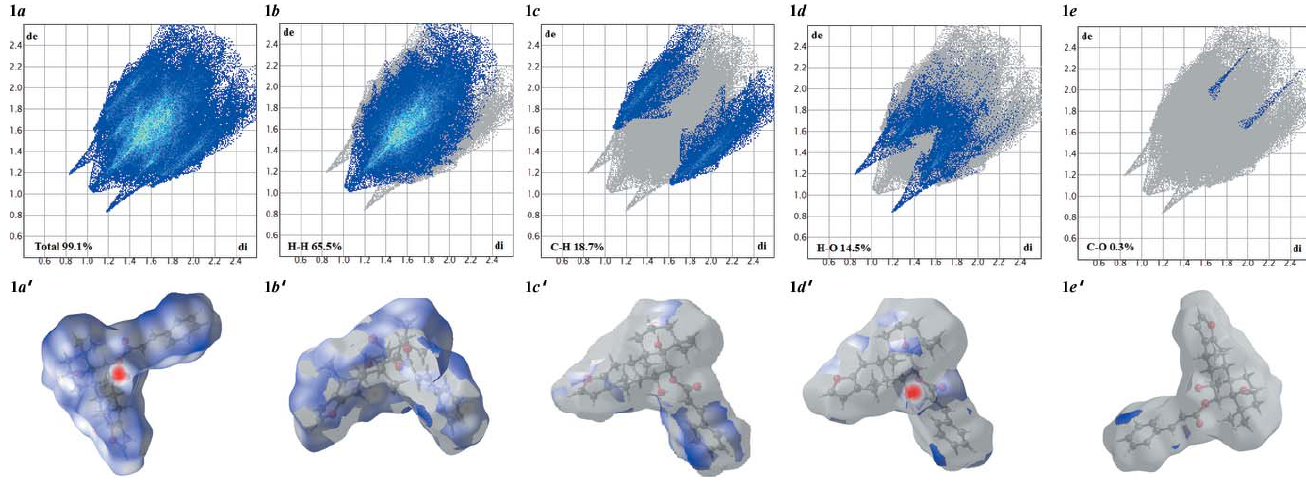
Figure 6 Two-dimensional fingerprint plots for compound (I).